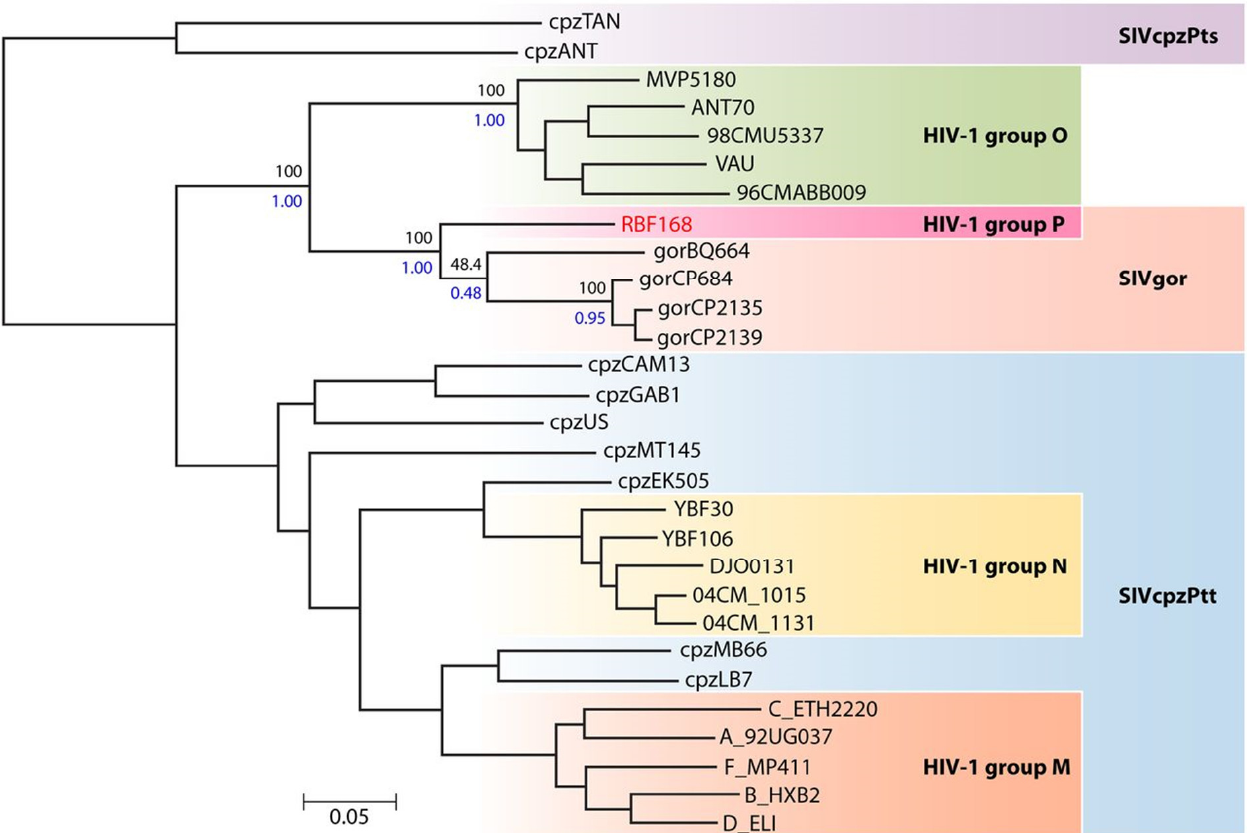
Figure 1. Phylogenetic relationships between the HIV-1, SIVcpz and SIVgor lineages (reprinted from reference [6] with permission of the publisher).